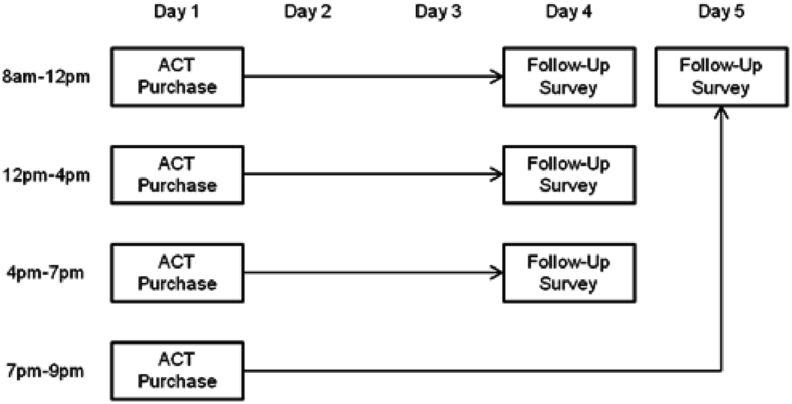
Timing of follow-up survey relative to time of ACT purchase. The follow-up survey was planned for 72 h after the time of the ACT Purchase. If people purchased ACTs after 7pm in the evening, the follow-up was scheduled for approximately 85 h later, that is the following day at 8am in the morning.